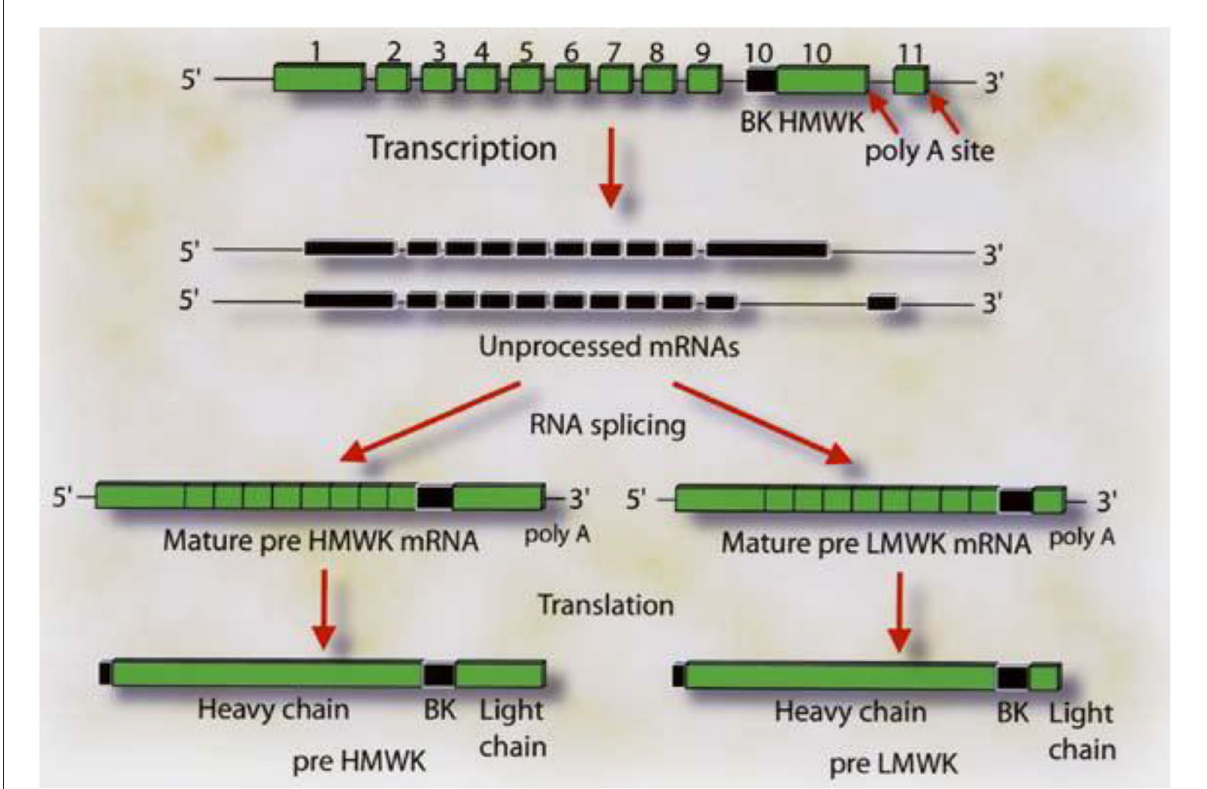
FIGURE5 The gene structure for HK and LK. The boxes labeled 1–9 represent the exon coding for the heavy chain of HK and LK. Exon 10 codes for the bradykinin sequence and the light chain of HK. The respective mRNA’s are assembled by alternative spicing events in which the light chain sequences are attached to the 3 ′ end of the 10 amino acid sequence C-terminal to bradykinin. Attachment of exon 10 in its entirety produces HK. Splicing of exon 10 (blackened portion) to exon 11 produces LK. Reproduced from Kitamura et al.